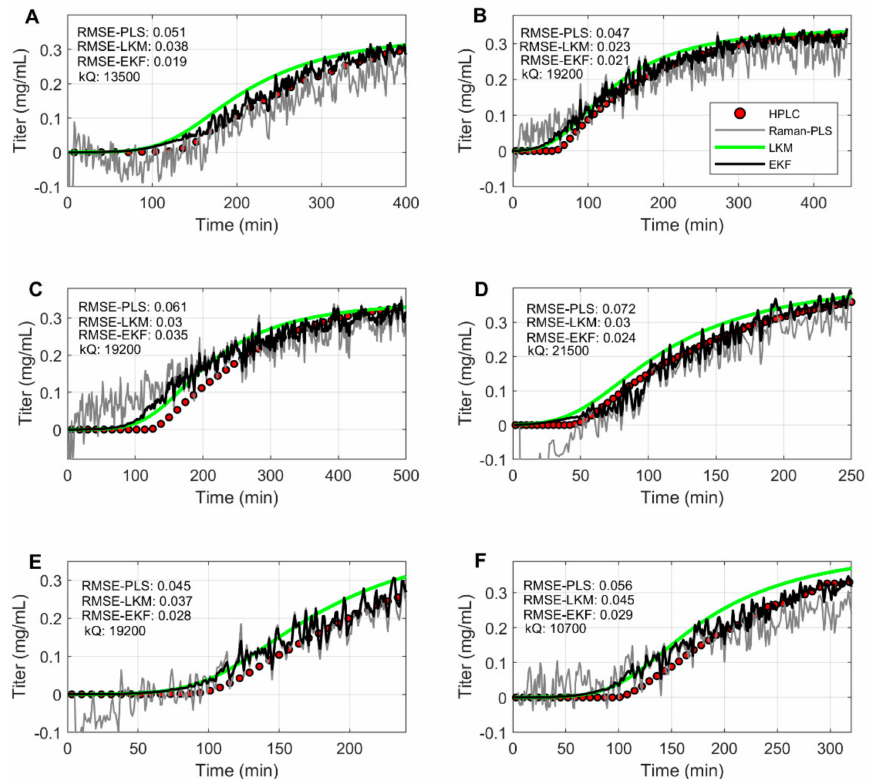
Figure 4. Titer predictions of Raman-PLS (grey), the LKM (green), the EKF model with tuned k Q (black) and HPLC o ff -line measurements (red) for rotations 1–6 ( A – F ).